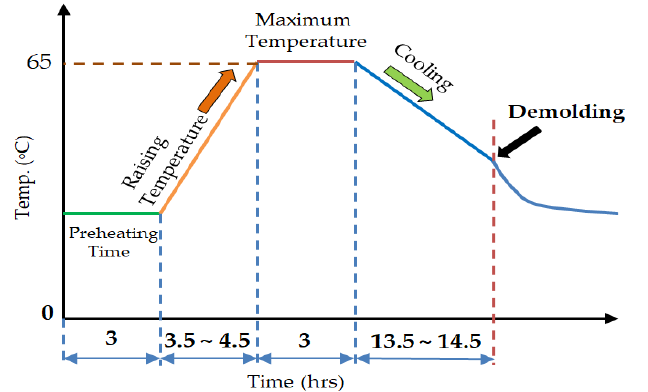
Figure 5. Target temperature history for accelerated curing.